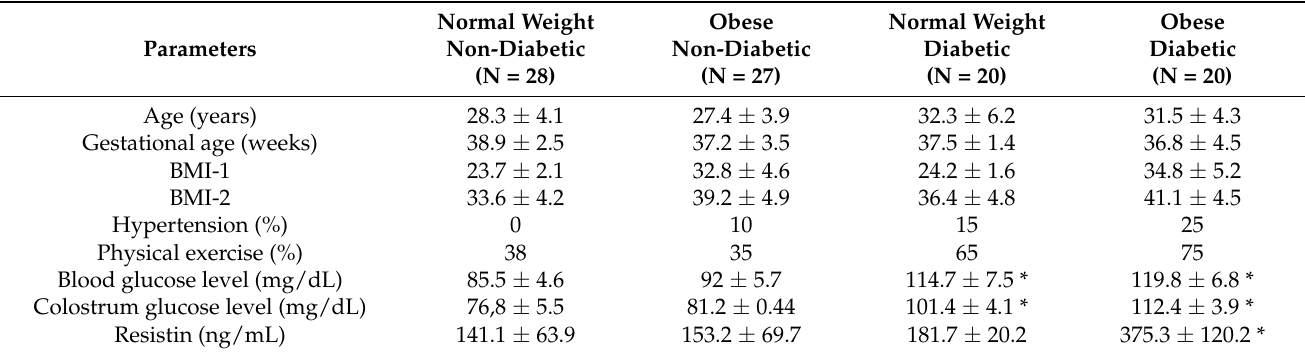
BMI-1: body mass index in the first trimester of pregnancy; BMI-2: body mass index in the third trimester of pregnancy (ANOVA, p < 0.05). * Significant differences between treatment groups (obese non-diabetics,